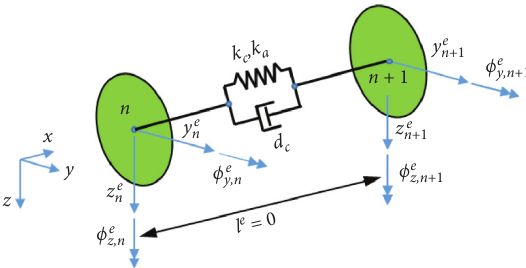
Figure 4: Zero-length contact